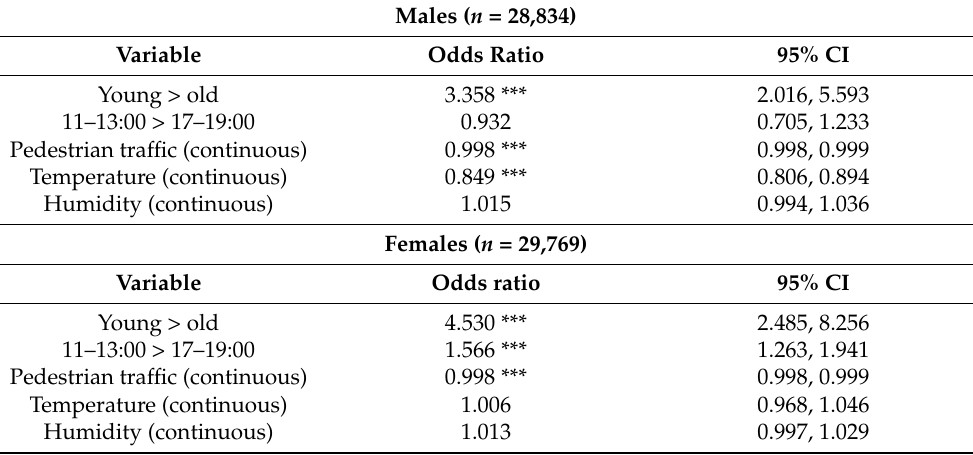
Table A1. Effects of the demographic and contextual variables on walking up the inclined travelator in male and female pedestrians on the Mid-Levels escalator system within the humidity range 47–76%.